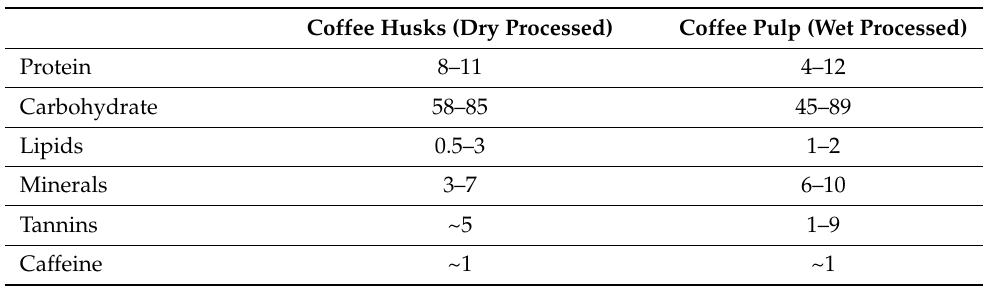
Table 2. Chemical composition of coffee husks and pulp (g/100 g dry basis). Own compilation based on literature data